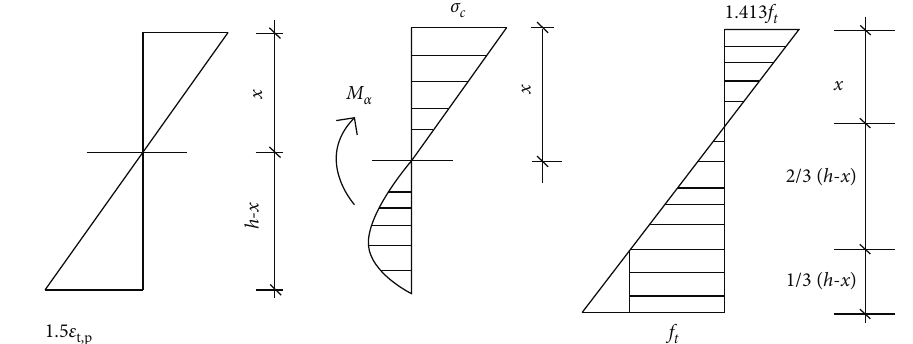
1.5 ε t,p Figure 9: Stress-strain relationship of RAC